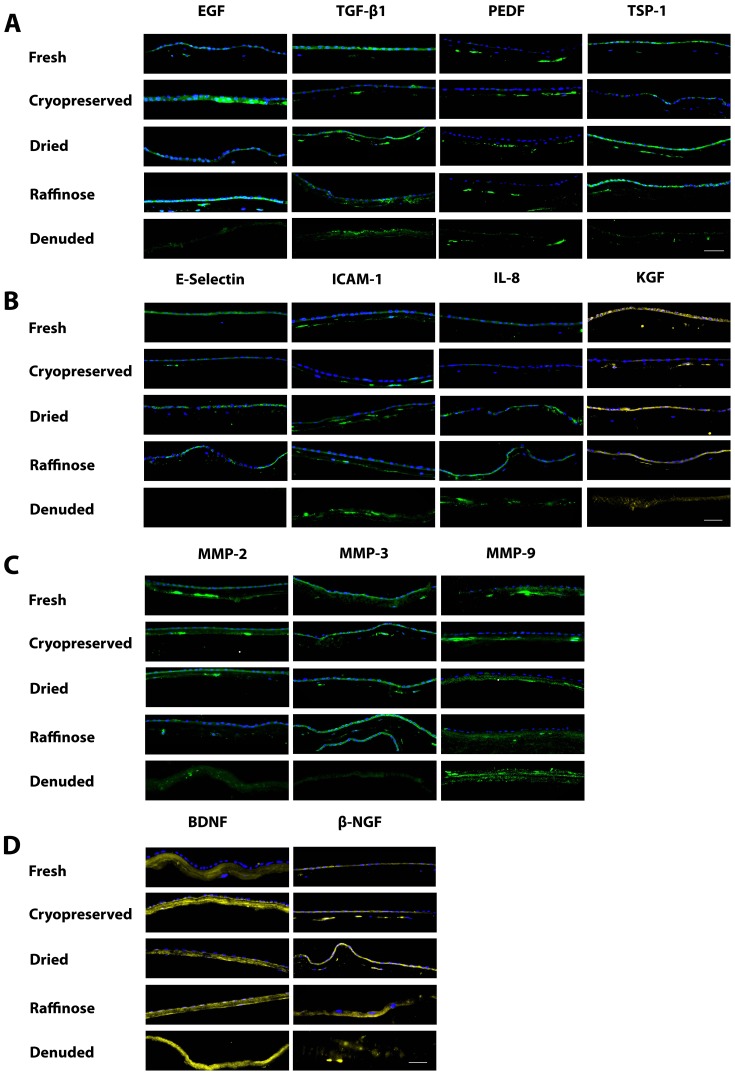
Expression of proteins with functions involved in ocular disease and wound healing in AM substrates.Proteins detected include growth factors and biomarkers (A) cell adhesion, cytokine and angiogenesis markers (B) metalloproteases and (C) neurotrophic factors (D). The collective pattern in staining demonstrates comparable levels of expression in trehalose and raffinose treated AM compared to fresh and increased expression compared to cryopreserved AM. Positive staining is represented as green or yellow and AEC nuclei were counterstained with DAPI (blue). Images shown are representative of triplicate experiments carried out on three donor membranes. Scale bar, 100 µm.